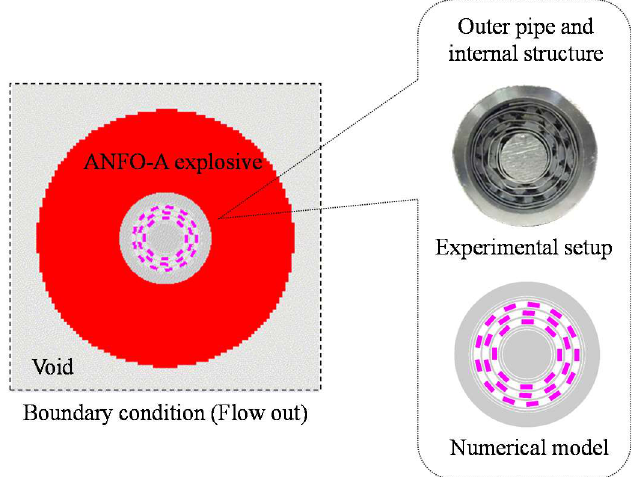
Figure 3. A two-dimensional computational model of the aluminium UniPore specimens.